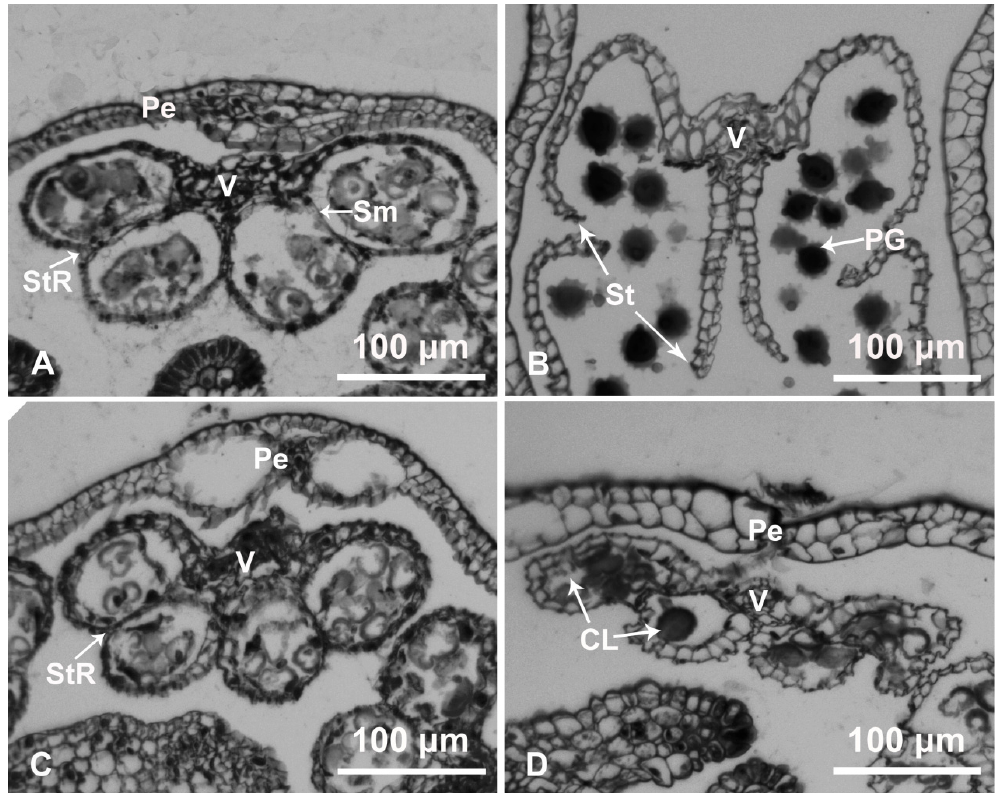
Figure 2. Cytological analysis of ‘Qx-097 ′ and ‘Qx-115 ′ anthers. ( A , B ) Paraffin-embedded sections of anthers of cultivar ‘Qx-097 ′ at period 1 ( A ) and period 2 ( B ). ( C , D ) Paraffin-embedded sections of anthers of cultivar ‘Qx-115 ′ at period 1 ( C ) and period 2 ( D ). Pe, petal; PG, pollen grain; Sm, septum; St, stomium; StR, stomium region; V, vascular region; CL, collapsed locule.